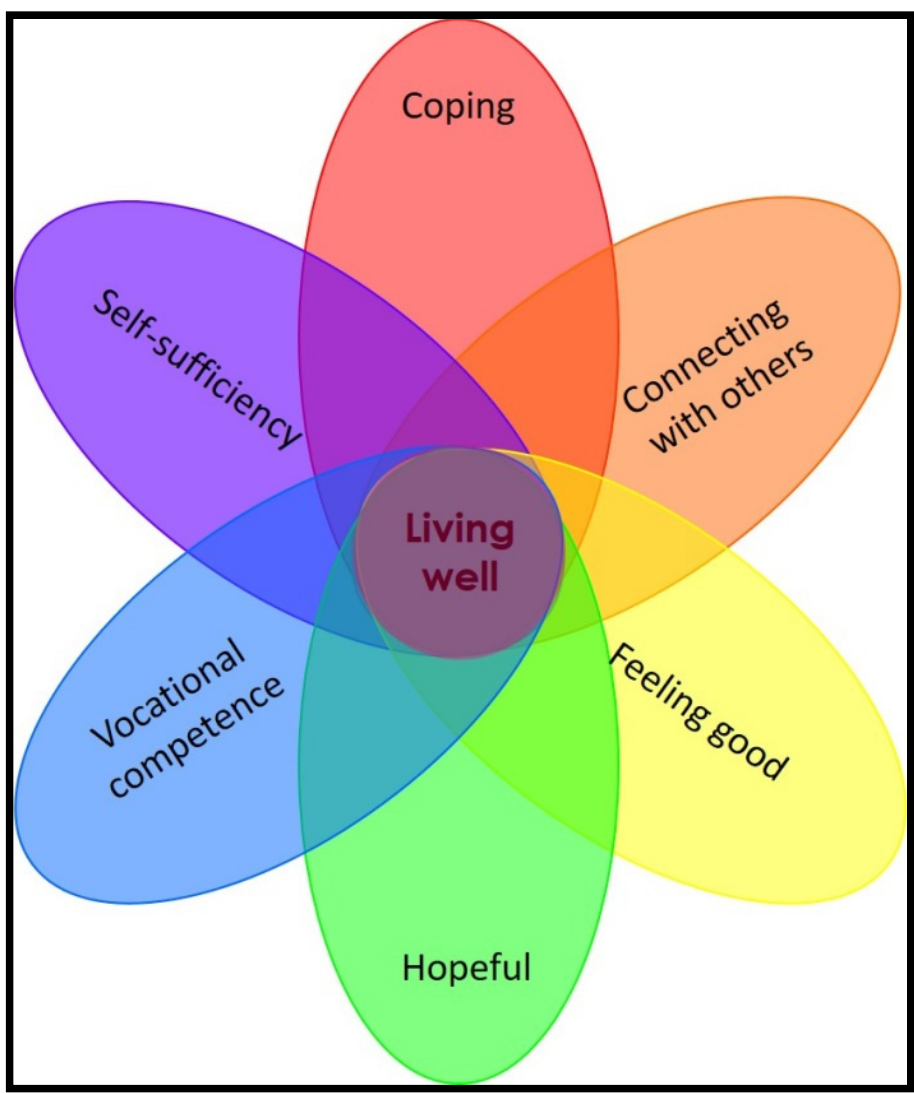
Figure 1. A conceptual framework, grounded in the scholarly literature, explaining what life skills young adults with disabilities need to acquire.